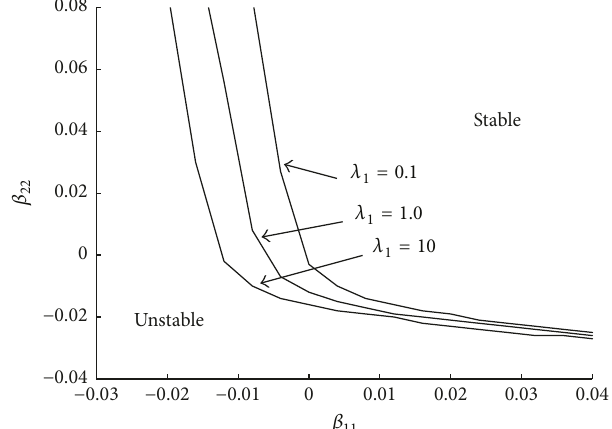
Figure3:Thestabilityboundariesinthe (𝛽 11 , 𝛽 22 ) planefordifferent transition rate 𝜆 1 when 𝜏 = 0.3 .